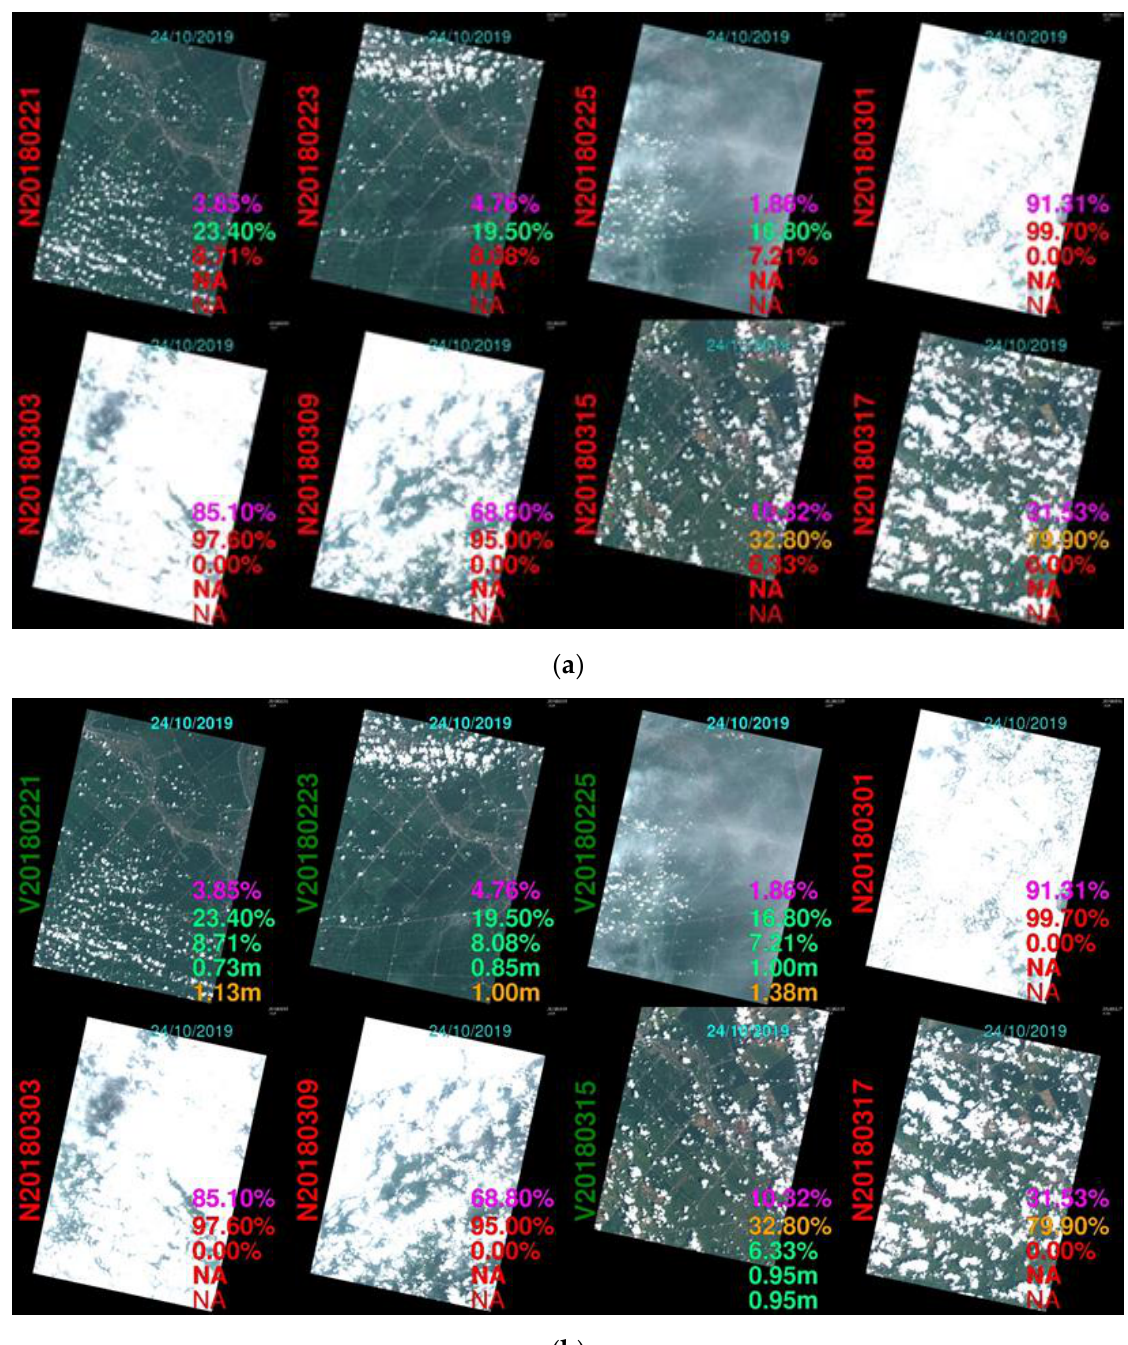
Figure 51. ( a ) ANGIANG site: 10% GEOVEN GIPP and Level-1 status; ( b ) ANGIANG site: 6% GEOVEN GIPP and Level-1 status.